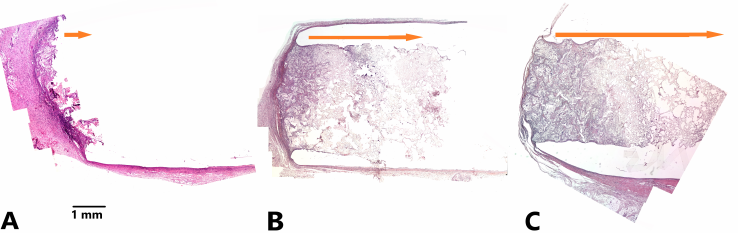
Figure 6. Histological evaluation of tissue reaction to scaffold-2 subcutaneous implantation on 7th ( A ), 14th ( B ), and 28th ( C ) days. Gradual germination of connective tissue into the cavity of the tubule along scaffold matrix can be observed. The arrow shows the direction of germination of loose connective tissue. Hematoxylin-eosin staining × 100. Original microphotographs ( A – C ) in good resolution are presented in Supplemental images for Figure